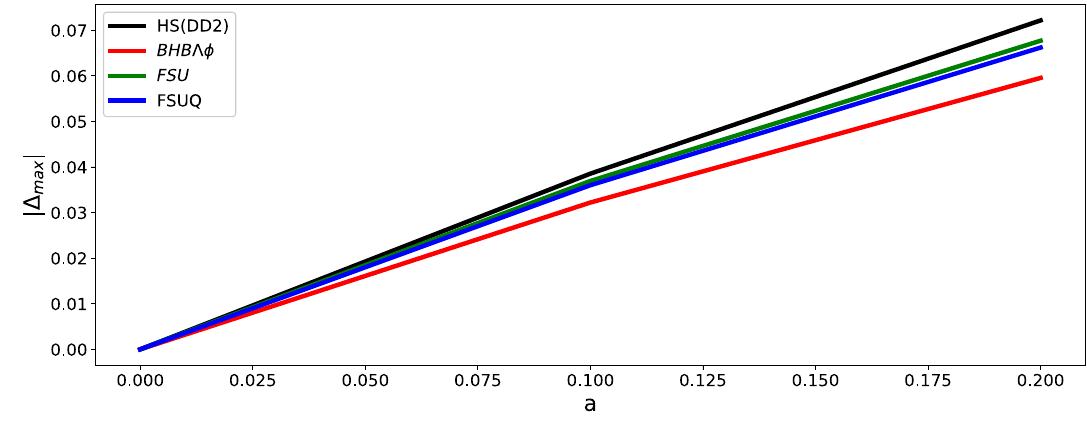
Fig. 6 | (cid:15) max | as a function of a for all EoSs in f ( R )